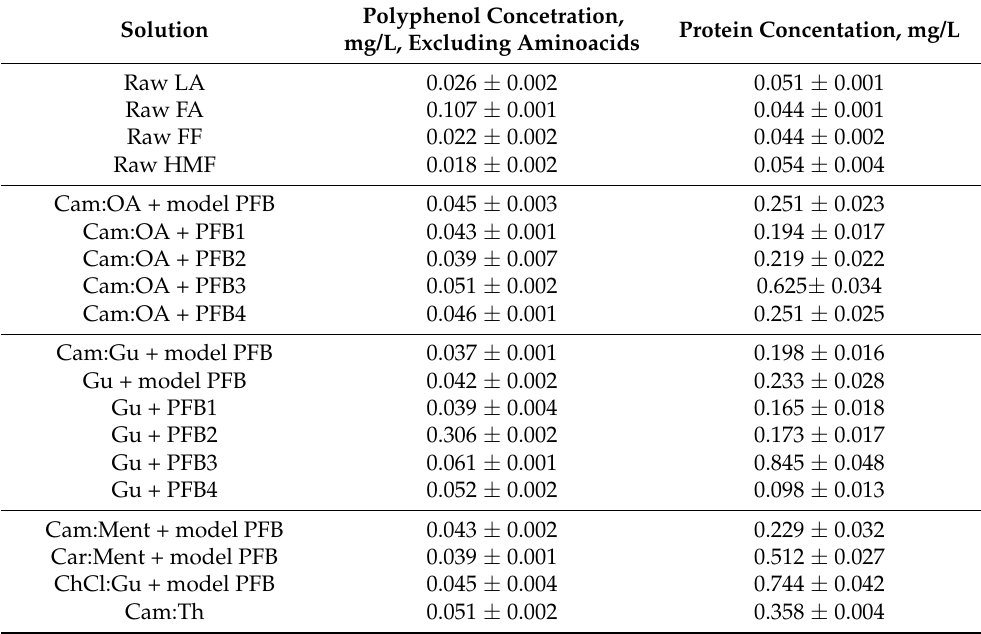
Table 5. The effect of DES on the protein and polyphenol concentration in post-fermentation broth with respect to the raw samples and samples after extraction